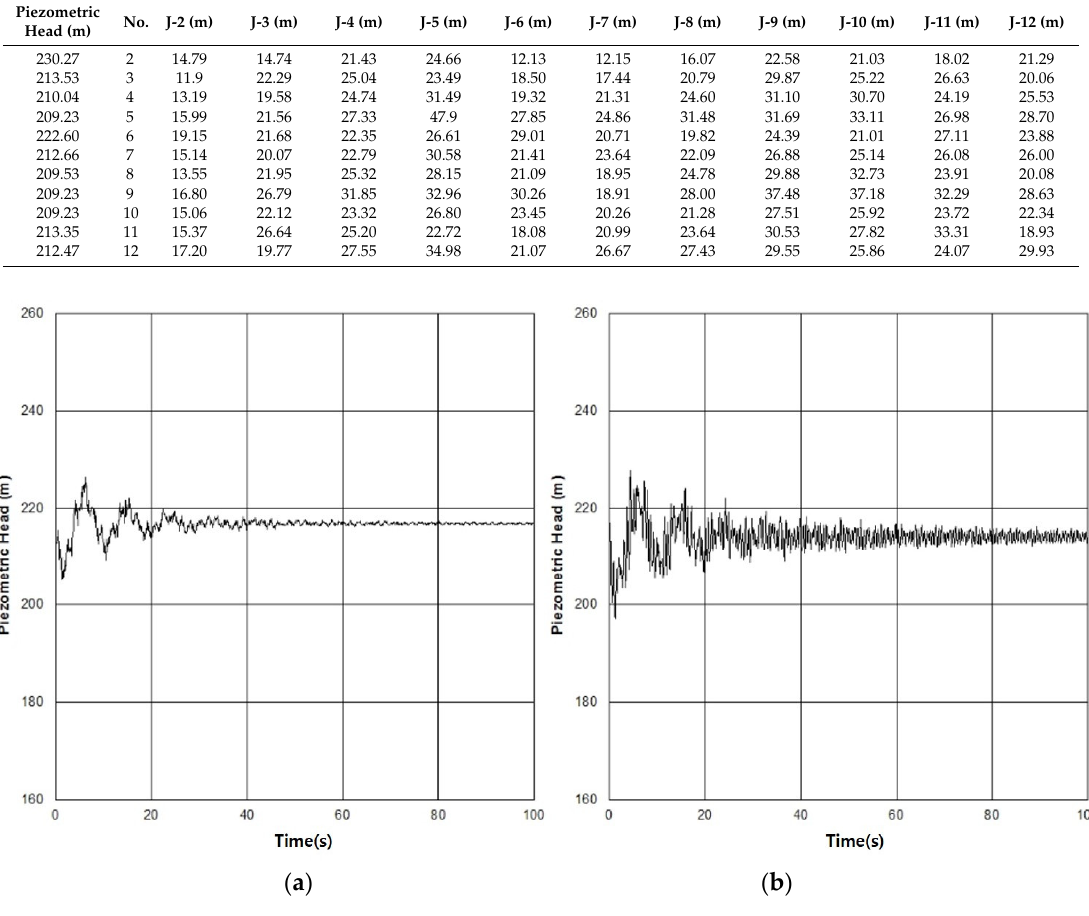
Figure 3. Pressure oscillations at ( a ) J-7 and ( b ) J-10.